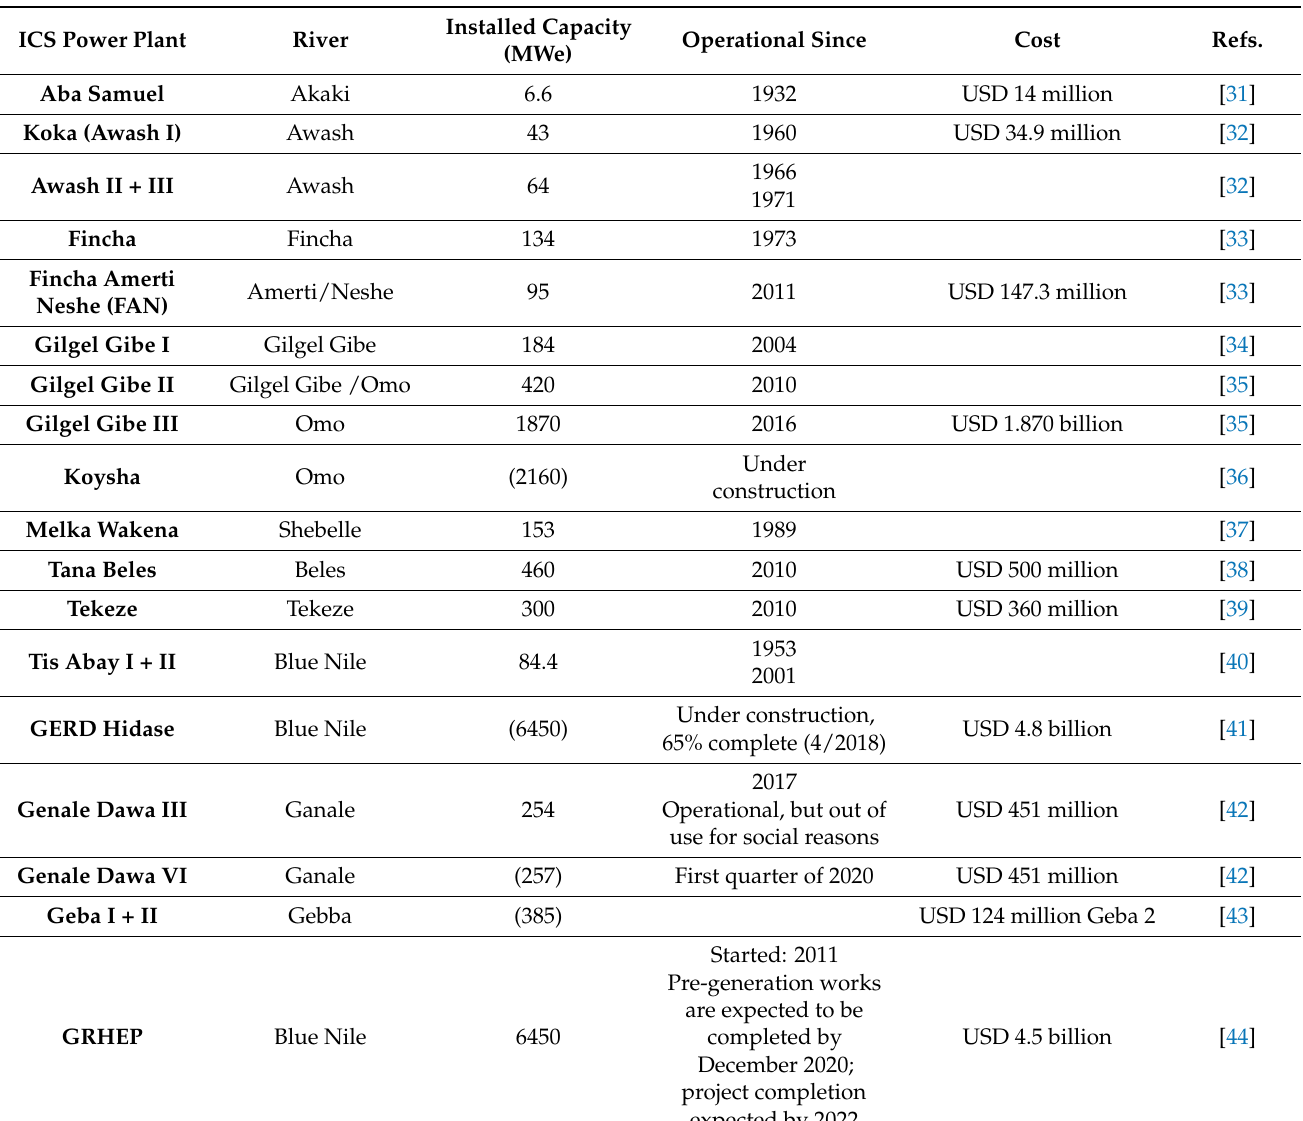
Table 4. Ethiopian hydropower plants.